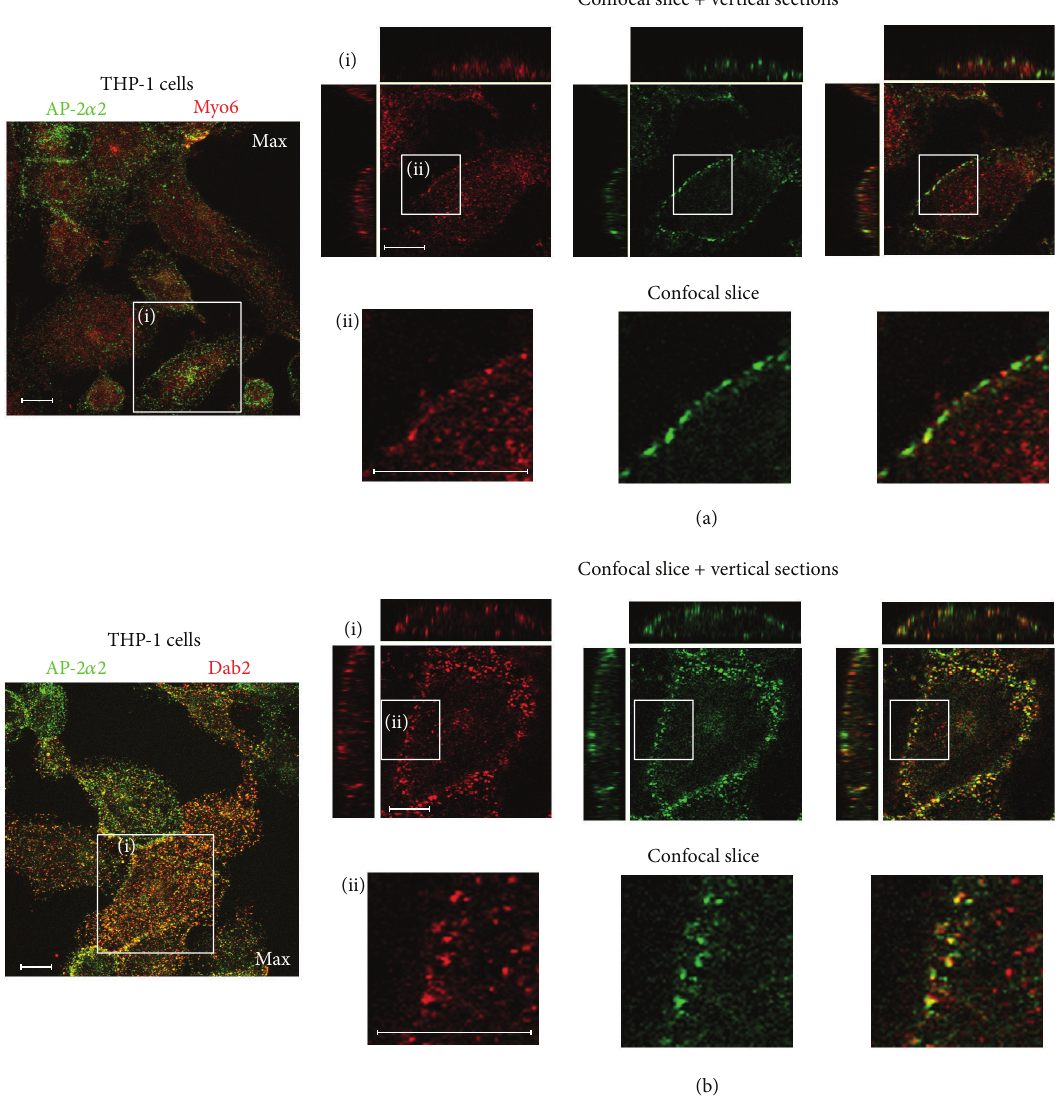
Figure 7: Relative distributions of AP-2 and Myo6 or Dab2 in THP-1 macrophages. THP-1 macrophages were fixed and probed using double immunofluorescencefor(a)AP-2 𝛼 2(secondaryantibodyconjugatedtoFITC(green))andMyo6(secondaryantibodyconjugatedtoAlexa555 (red)); (b) AP-2 𝛼 2 (secondary antibody conjugated to FITC (green)) and Dab2 (secondary antibody conjugated to Alexa555 (red)). Z-stacked images were taken on a Leica SP5 confocal microscope. Maximum projections are shown on the left for orientation. Series labeled (i) show single confocal sections and vertical xz and yz sections through the centre of the cells indicated to the left. The individual channels for Myo- 6 or Dab2 (red), AP-2 𝛼 2 (green), and the overlay are shown side-by-side. Enlargements of the single confocal slice, showing the plasma membrane, are shown in series (ii) and show the regions indicated in (i). Typical images from at least 3 separate experiments with THP-1 cells or HMDM from 3 individual donors are shown. Scale bars = 10 𝜇